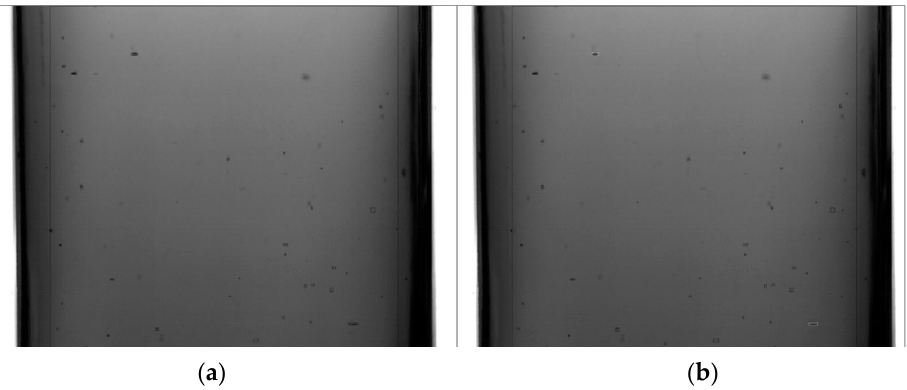
Figure 13. Example of improvement in detection of seeds. ( a ) the image has been processed with the classical image processing approach; ( b ) the image has also been processed with the deep learning- based model.